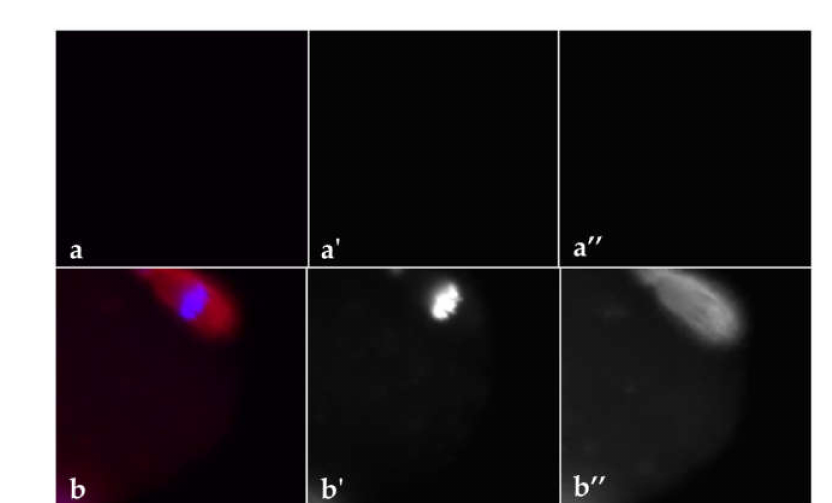
Figure 3. Representative images of MII plate observed in oocytes from control ( a–a” ) and DHEA ( b–b” ) mice following induction of ovulation. Spindle is stained by α -tubulin (red) and chromosomes are stained by Hoechst 33342 (blue). Five mice per experimental group were employed. Experiments were done in